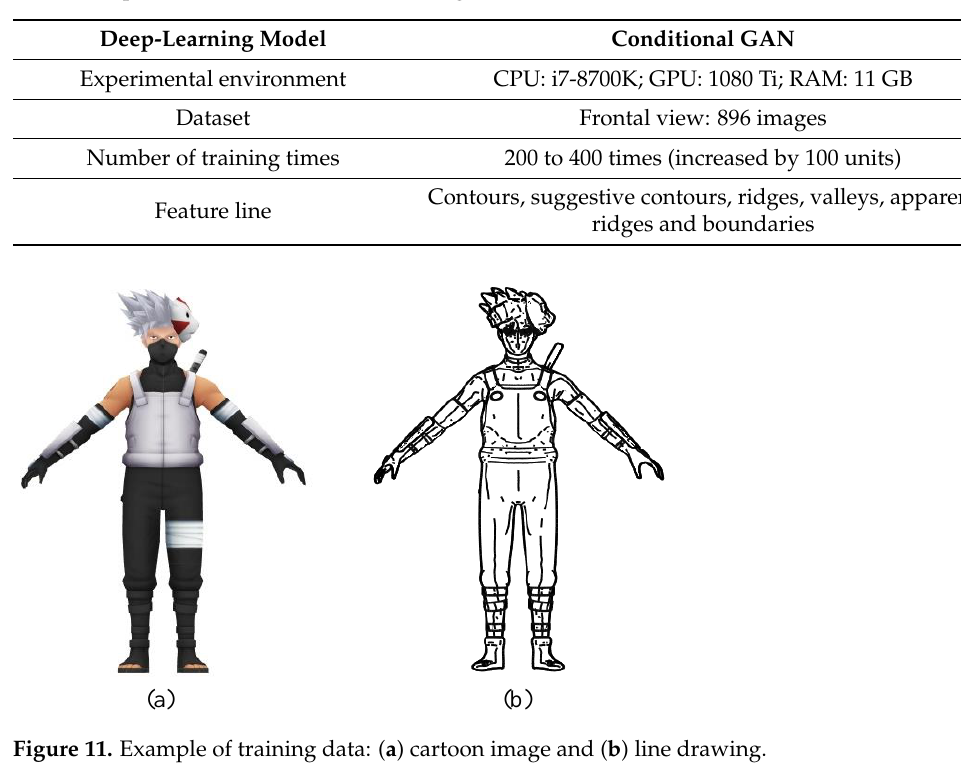
Figure 10. Conditional GAN training for line drawing extraction from 2D cartoon images.